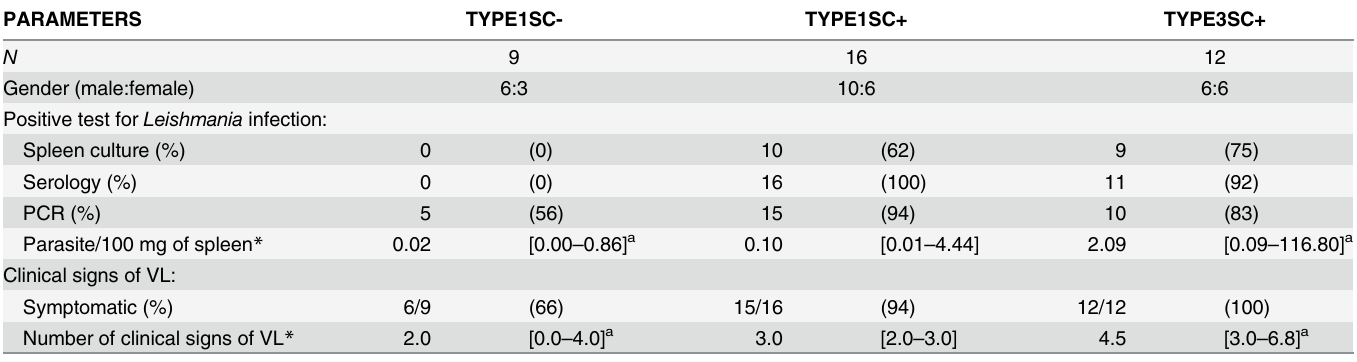
Table 2. General characteristics of included non-infected dogs, dogs without active infection with organized white pulp (TYPE1SC), infected dogs with organized white pulp (TYPE1SC+) and infected animals with disorganized white pulp (TYPE3SC+).